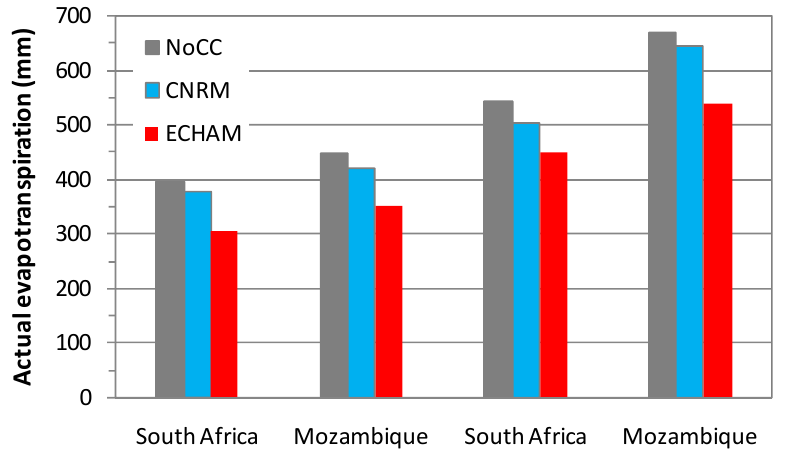
Figure 10. Simulated mean annual actual evapotranspiration under the 1971–2000 climate baseline and climate change scenarios for